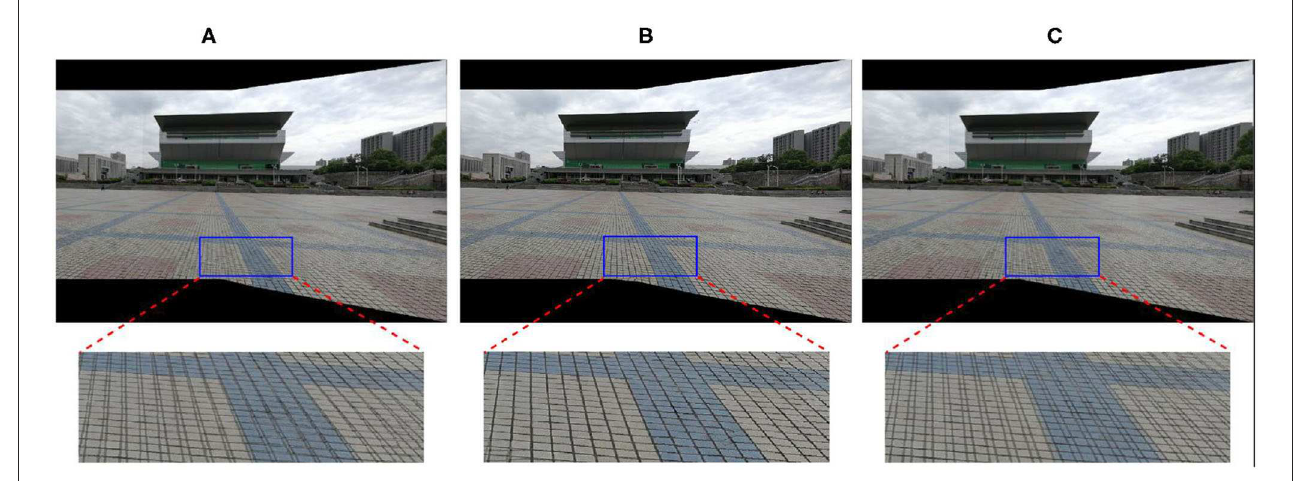
FIGURE5 Comparisons with APAP and global homography. (A) APAP, (B) our method, and (C) global